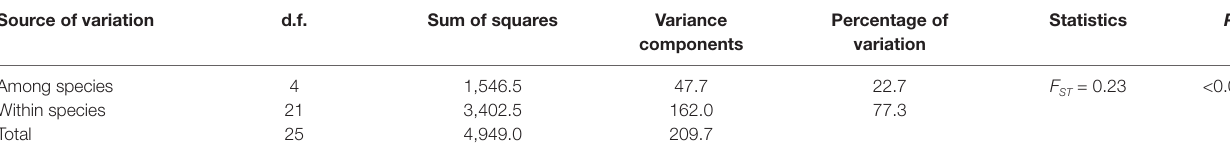
TaBle 2 | Analysis of molecular variance (AMOVA) testing genetic subdivision among all species.